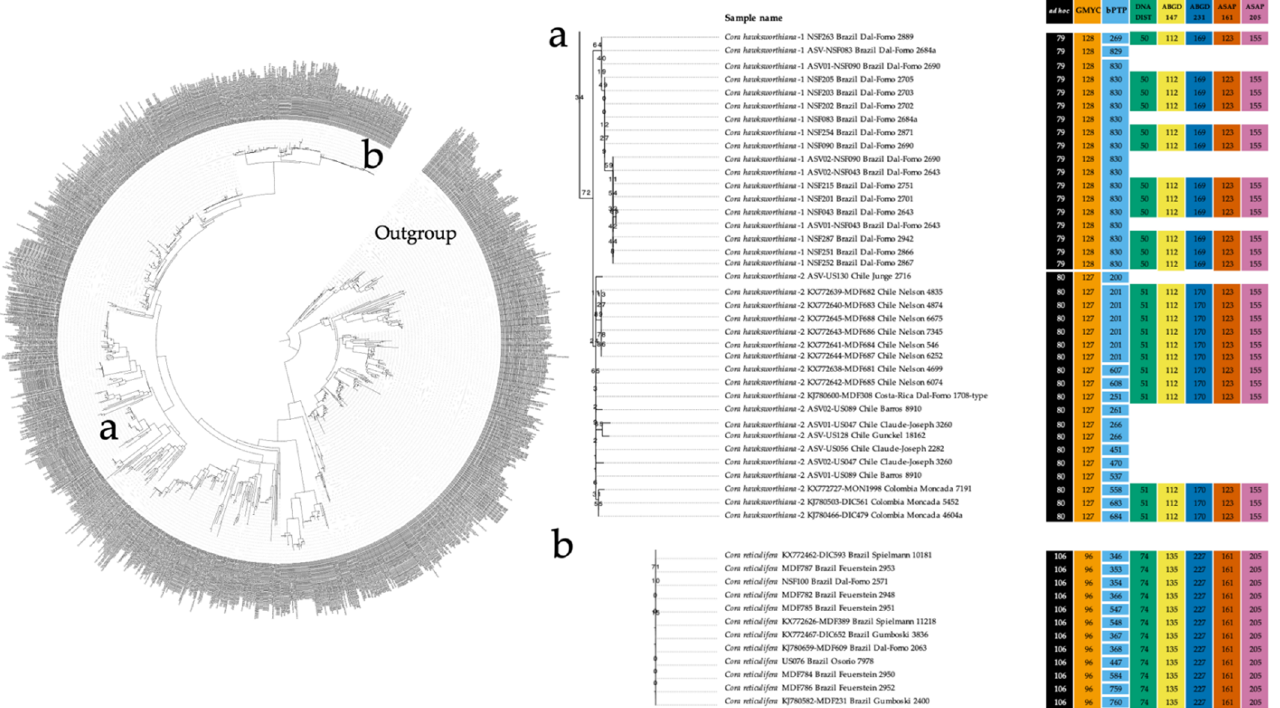
Figure 5. ITS fungal barcoding tree inferred by maximum likelihood for the genus Cora , including the Acantholichen ‐ Corella clade as outgroup (1325 terminals), and two examples of the results of species delimitation approaches. Cora hawksworthiana ( a ) is currently considered a single species, but could potentially be further divided into two—one from Brazil and another for Chile, Colombia, and Costa Rica—based on the ad hoc, GMYC, DNADIST, and ABGD ‐ 231 approaches. In contrast, Cora reticulifera ( b ), an abundant common species from southeastern Brazil and Uruguay, with a uniform phenotype and ecology, was delimited as a single species by all methods, except in bPTP, which recovered each sample as a separated species. For the full-length tree as well as species delimitations for all specimens, see Figure S1 and Table